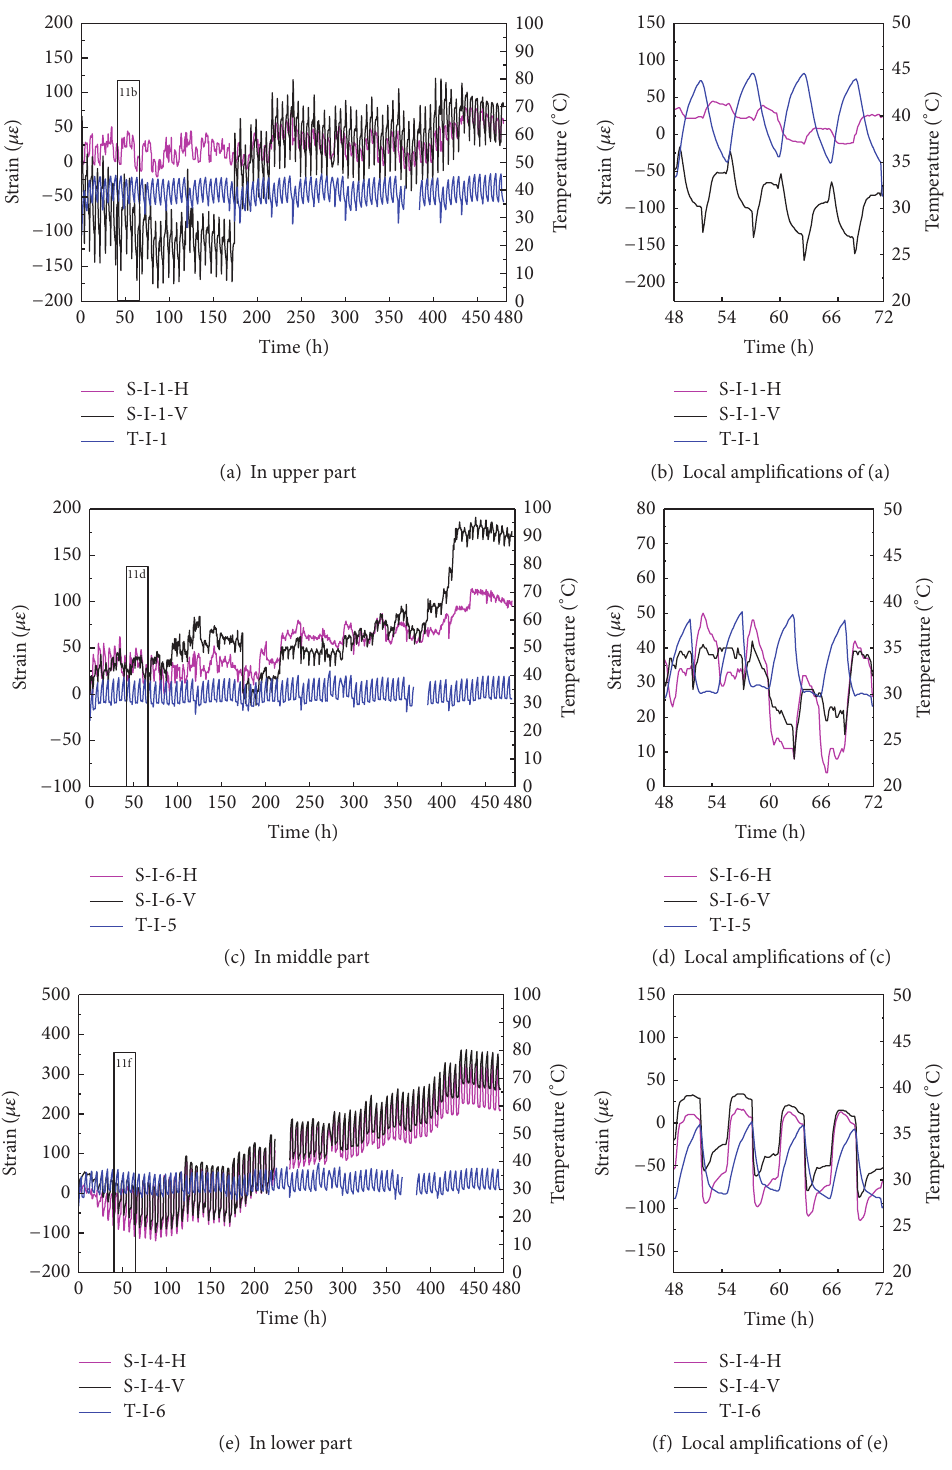
Figure 11: Strain-time-temperature relationship of bonding